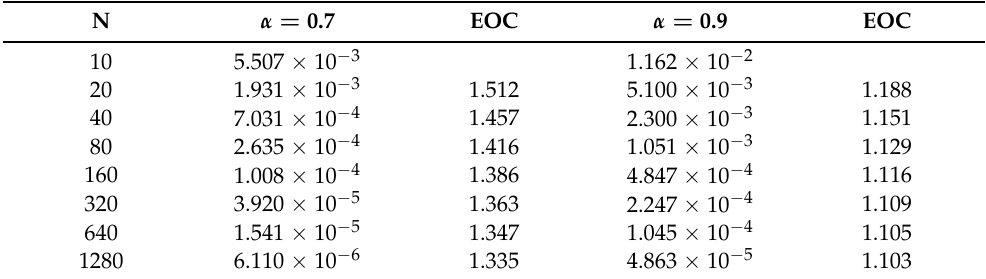
Table 4. Table showing the maximum absolute error and EOC for solving (53) using the predictor– corrector method for 0.5 < α < 1.